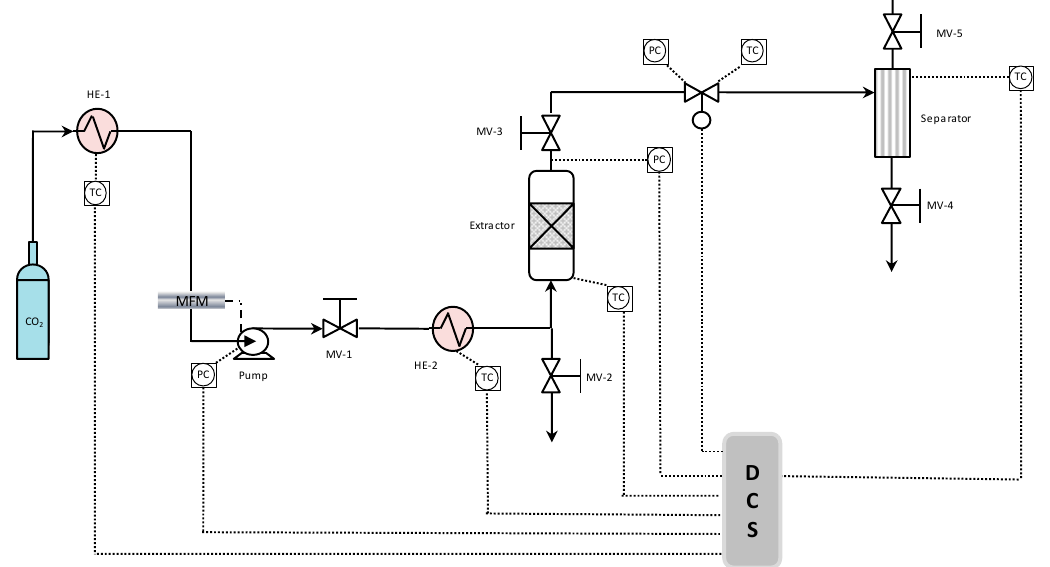
Figure 4. Bench scale SF-CO 2 extraction unit schematization. Note: HE: Heat exchanger; MFM: Mass flow meter; MV: Manual valve; DCS: Distributed control system; PC: Pressure control; TC: Temperature